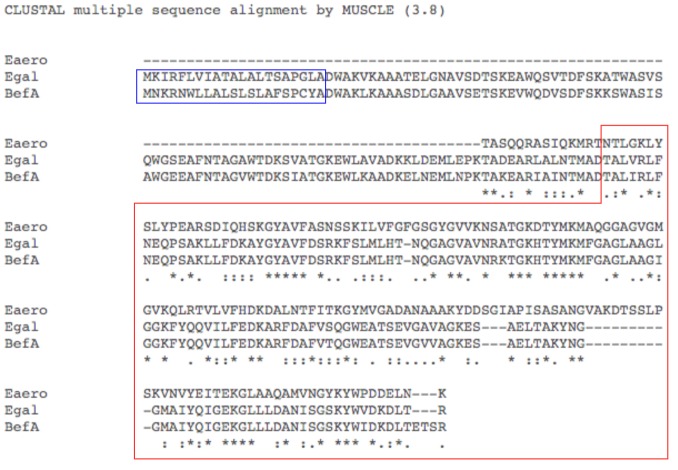
Amino acid sequence alignment of BefA and functionally conserved homologs.Amino acid sequence alignment by MUSCLE.Egal = Enterococcus gallinarum homolog sequence, Eaero = Enterobacter aerogenes homolog sequence, and BefA = original Aeromonas veronii HM21 BefA sequence. Red box contains predicted SYLF domain. Blue box indicates predicted secretion peptides.